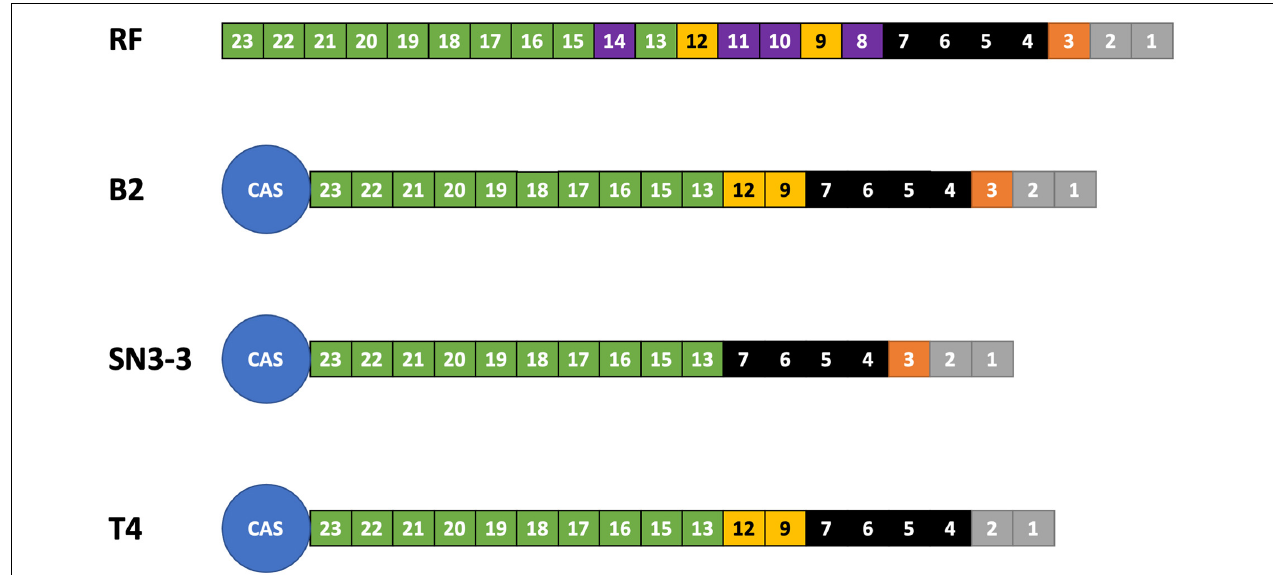
FIGURE 2 | CRISPR spoligotyping. Overview of the CRISPR/Cas locus. The reference (RF) array annotation is based on X. citri 306 (CP009016). The colors of the boxes indicate spacer sequences that correspond to the reference. Purple: absent in the sequenced genomes of this